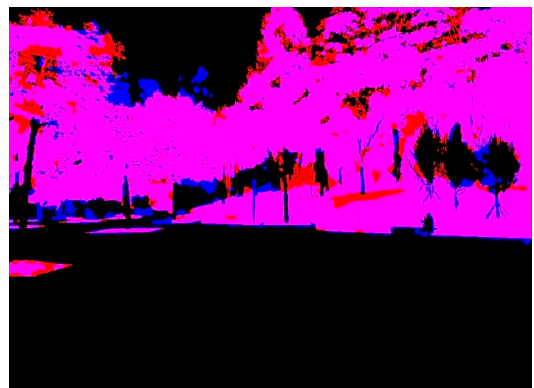
Figure 5. Comparison effect of green pixel extraction algorithm. The purple part is the correctly extracted region of pixels, the red part is the actual green region that was not extracted, and the blue part is the non-green region that was incorrectly extracted by the algorithm.